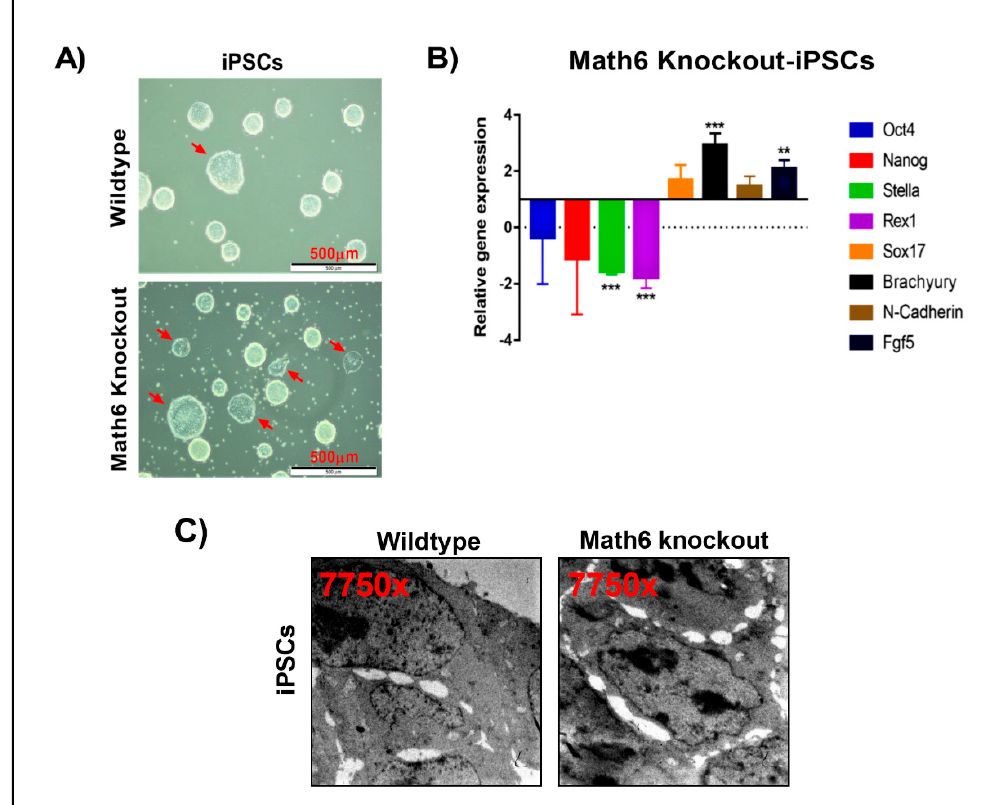
Figure 5. Math6 sustains the naïve pluripotent state. ( A ) WT and KO iPSCs maintained in 2i/LIF medium. KO-iPSCs show more primed colonies. ( B ) Expression of pluripotent markers ( Oct4 & Nanog ), naive markers ( Stella & Rex1 ) and primed state markers ( Sox17, Brachyury, N-Cadherin, Fgf5 ) in KO-iPSCs. The gene expression shown is normalized to 18s and relative to WT-iPSCs. Statistical significance levels are shown as ** p ≤ 0.01 and *** p ≤ 0.001. ( C ) Transmission electron microscope images showing WT and KO iPSCs. KO-iPSCs show poor cell-cell contacts compared to WT-iPSCs.